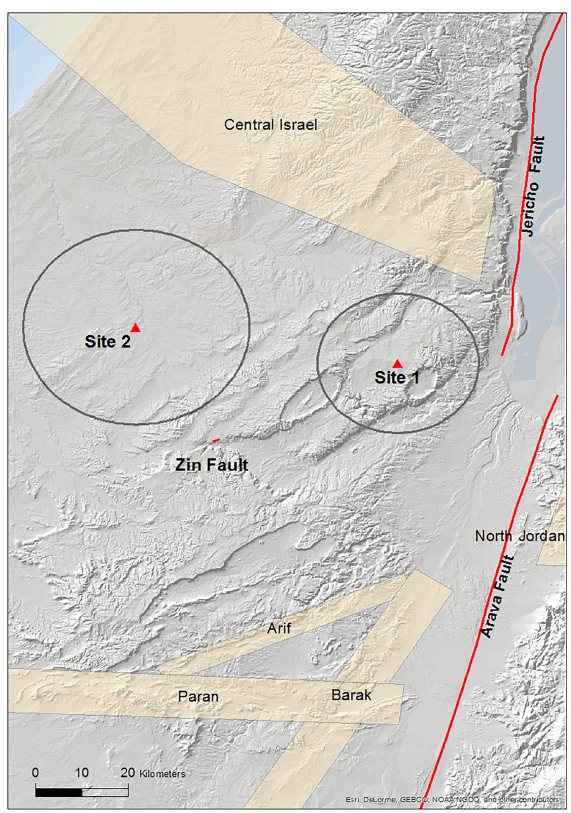
Figure 4. Model 4, showing the two sites and their respective near- site